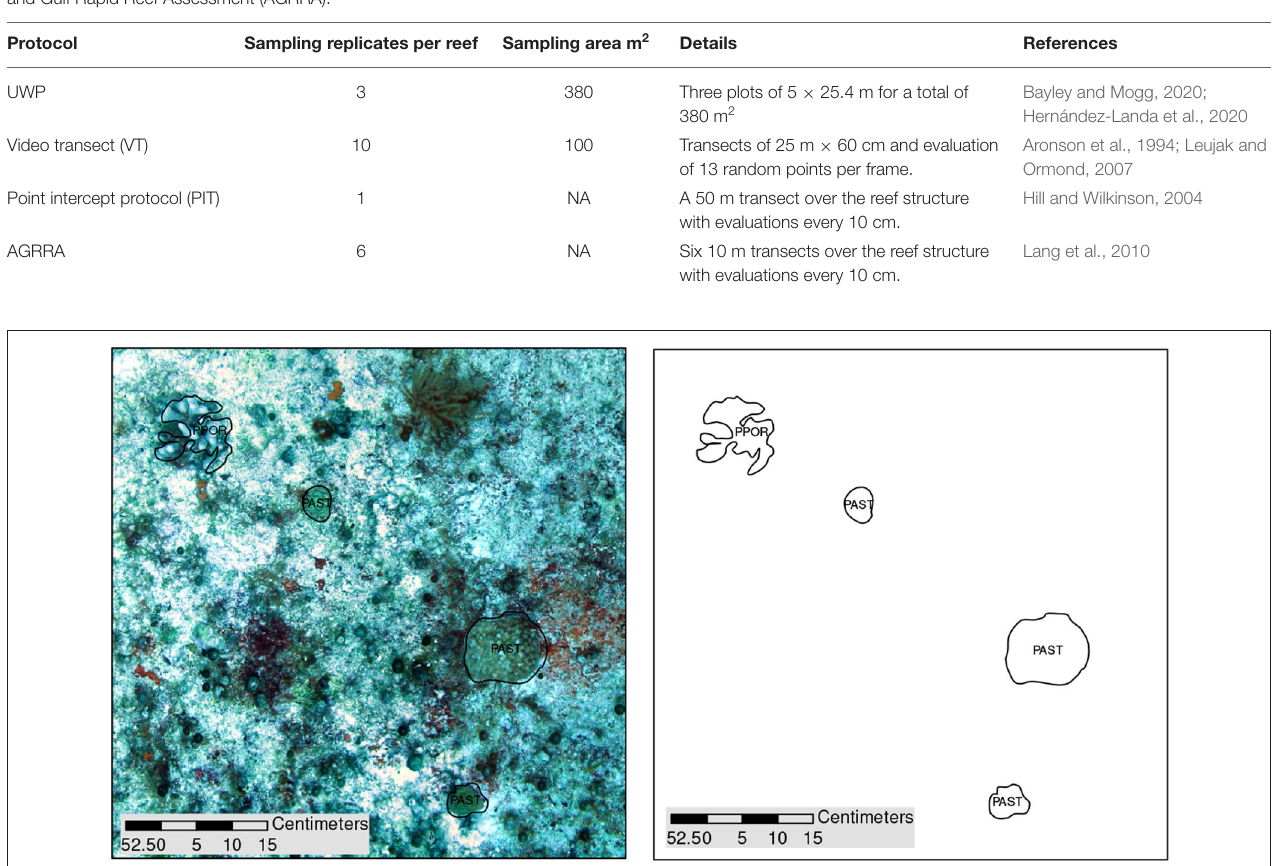
TABLE 1 | Sampling protocols used for benthic communities, underwater digital photogrammetry (UWP), videotransect (VT), point intercept transect (PIT), and Atlantic and Gulf Rapid Reef Assessment (AGRRA).